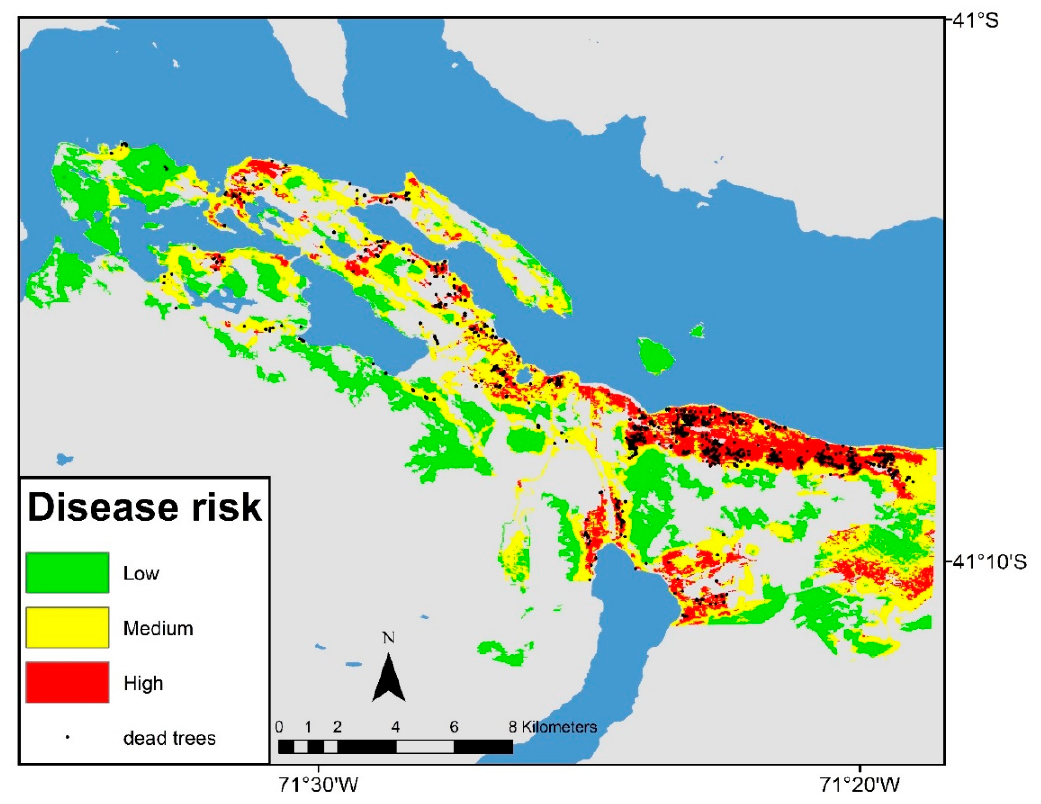
Figure 6. Distribution of Austrocedrus disease risk categories in San Carlos de Bariloche county. Black points correspond to the Austrocedrus disease occurrence layer used to generate the MaxEnt model.